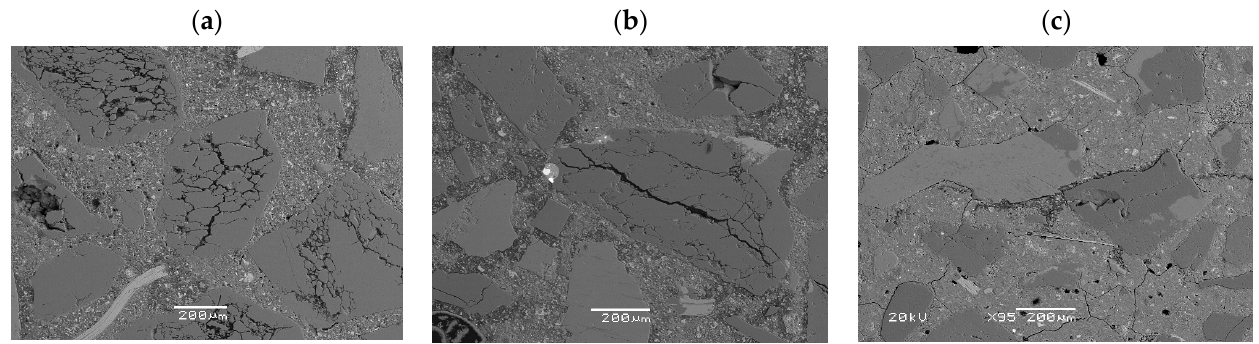
Figure 7. Cracking and microcracking in aggregate and in cement matrix in analyzed specimens: ( a ) reference, 0% of calcined clay, ( b ) 10% of clay calcined at 850 °C, ( c ) 20% of clay calcined at 850 °C.